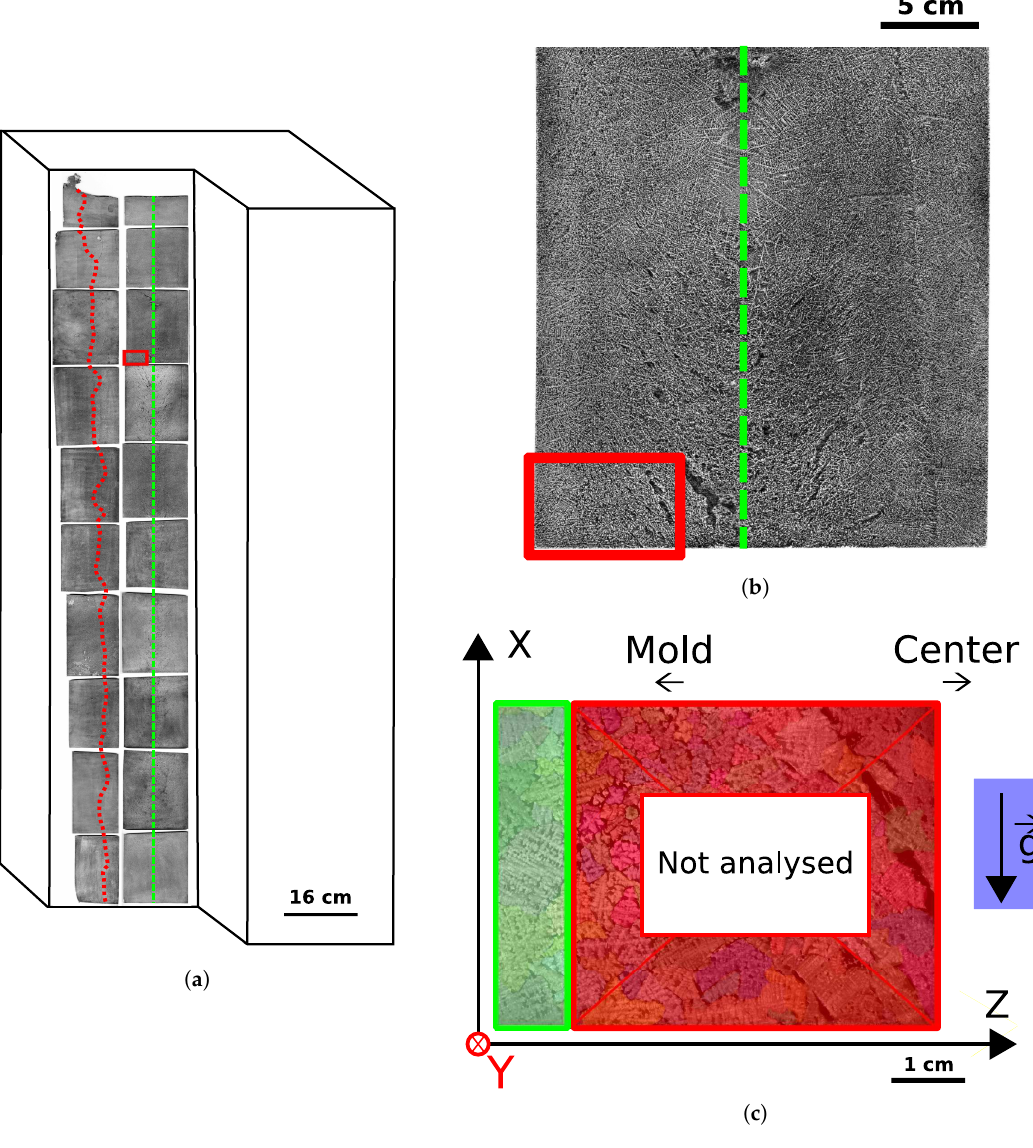
Figure 1. Description of the sample position in a 6.2ton 100Cr6 ingot. The total height of the ingot is 267cm. The red dotted line is the columnar-to-equiaxed transition. The green dashed line is the central axis of the ingot. ( a ) Macroetched central slice inside a 3D schematic view of the ingot. ( b ) Position of the sample for serial cutting. ( c ) Zoom on the red rectangle with the position of the serial cut metal in the green rectangle. The normal vector to the slices is directed along the Z